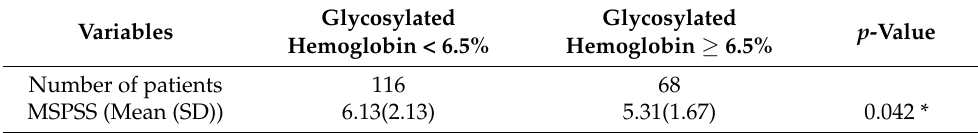
Table 4. Relationship between variables stratified by glycemic control